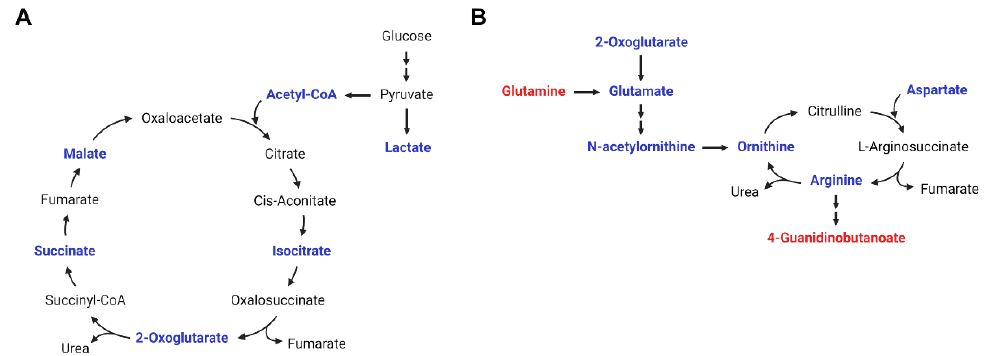
Figure 4. Metabolic pathway changes by weight-loss intervention. ( A ) TCA cycle and ( B ) arginine biosynthesis and urea cycle. (Red, metabolites increased in plasma at 18 months post-intervention compared to at baseline; blue, metabolites decreased in plasma at 18 months post-intervention compared to at baseline).